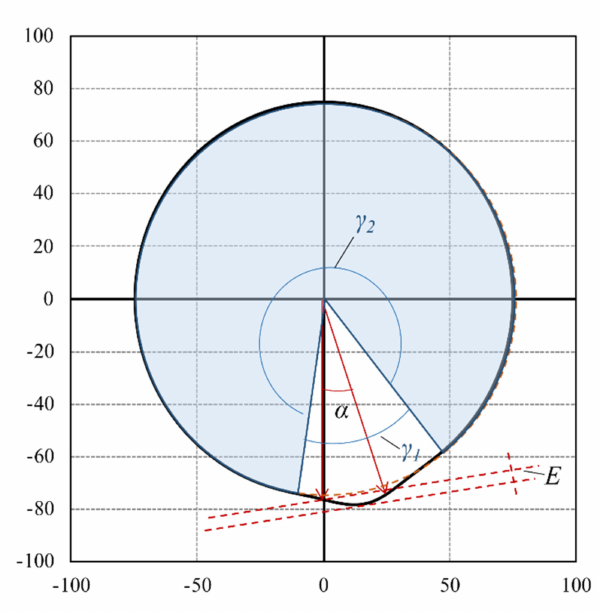
Figure 15. Schematic diagram of a cam plate.